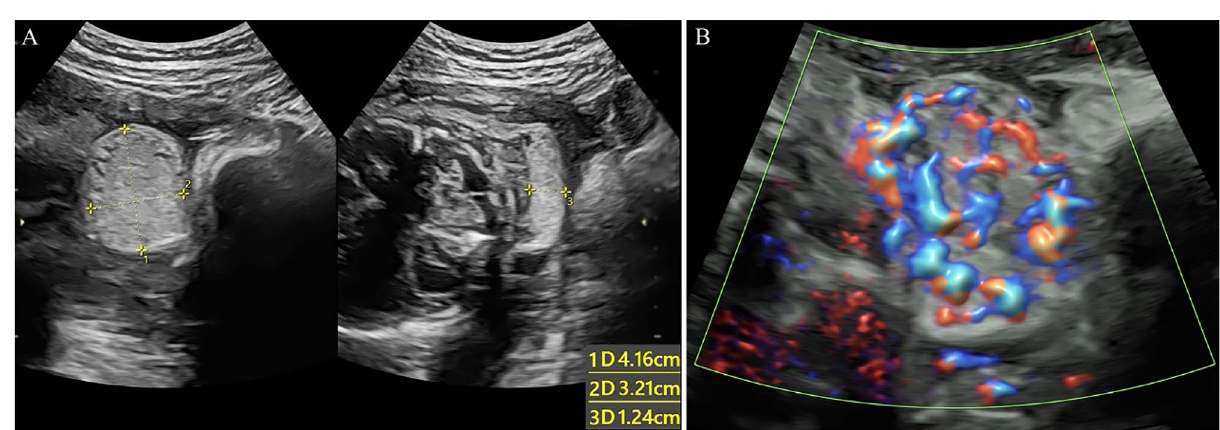
Figure 4. A hemangioma at 26 weeks of gestational age. ( A ) Prenatal ultrasound exhibited a hyperechogenic lesion (4.16 × 3.21 × 1.24 cm) located at the left of the neck. ( B ) Color Doppler ultrasound of blood flow showed rich blood flow signals inside the